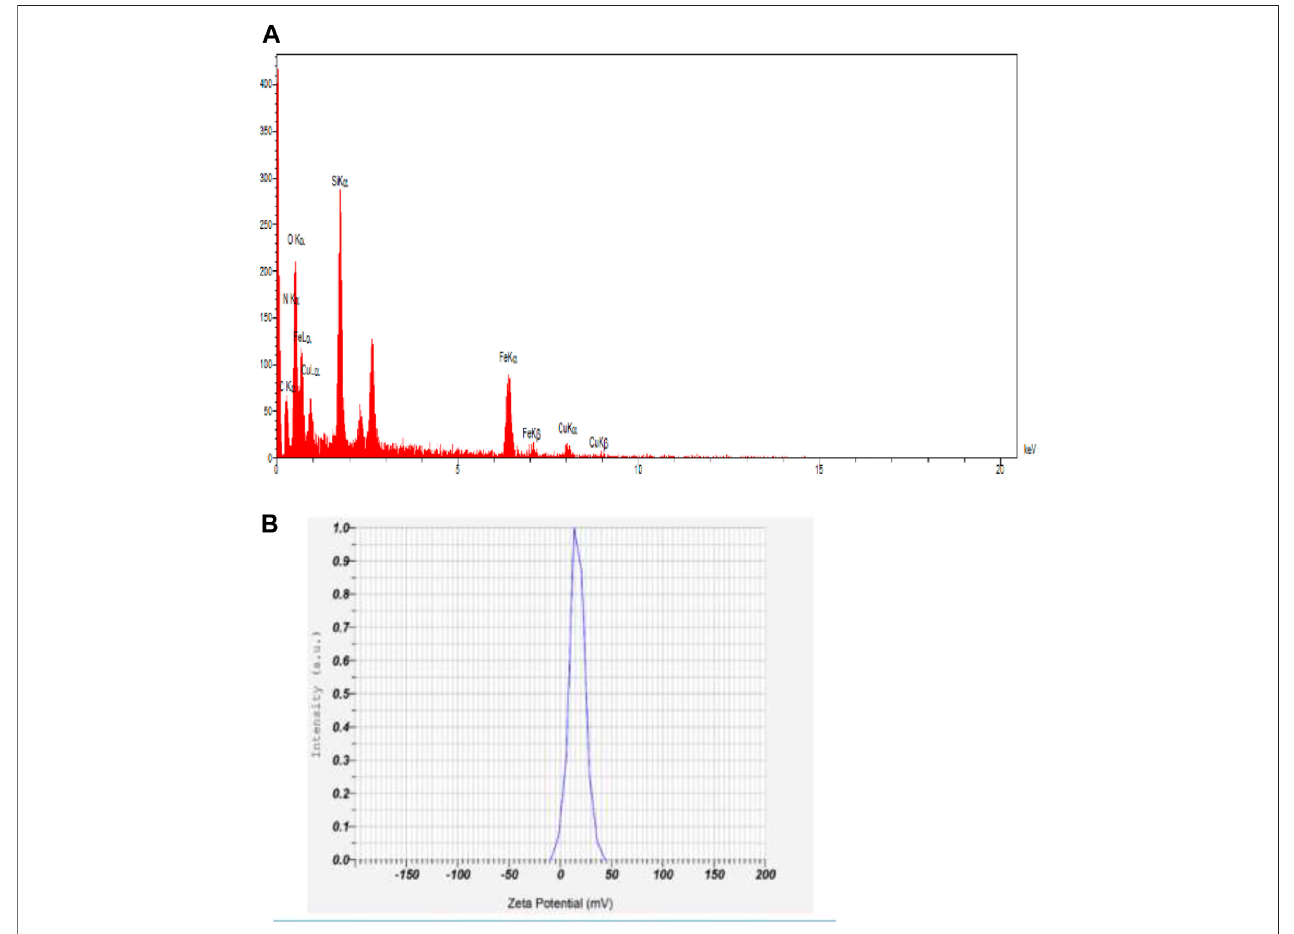
FIGURE 4 | (A) Zeta potential and (B) EDX analysis of Fe 3 O 4 @SiO 2 -propyl@dapsone-Cu complex.